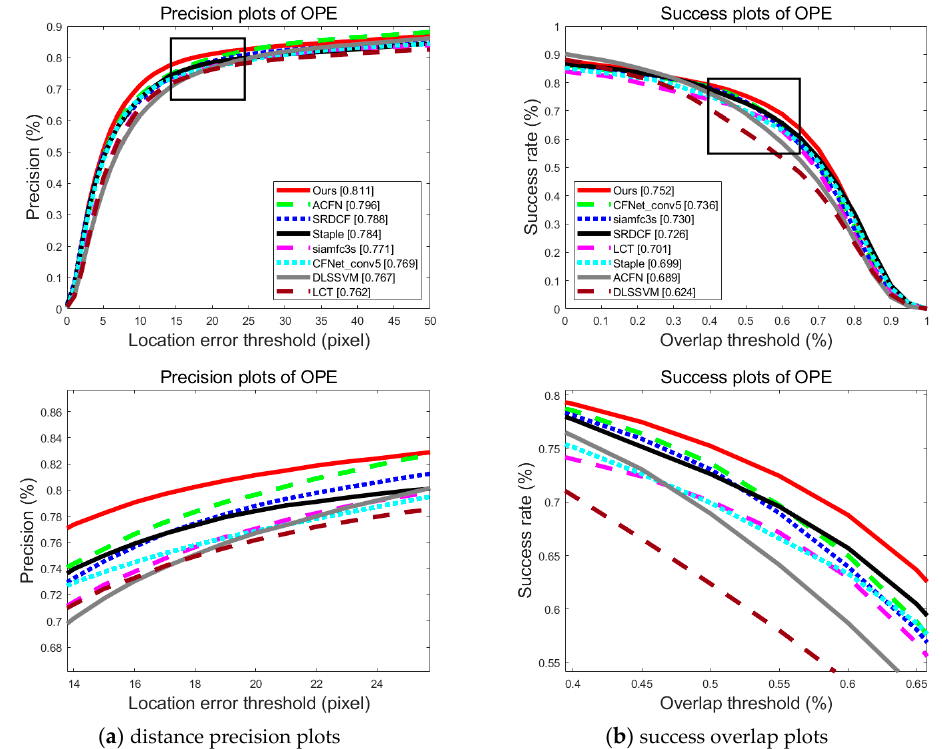
Figure 6. Precision plots and success plots of OPE on OTB2015 datasets. Expanded performance of the black box is shown under the corresponding curve.